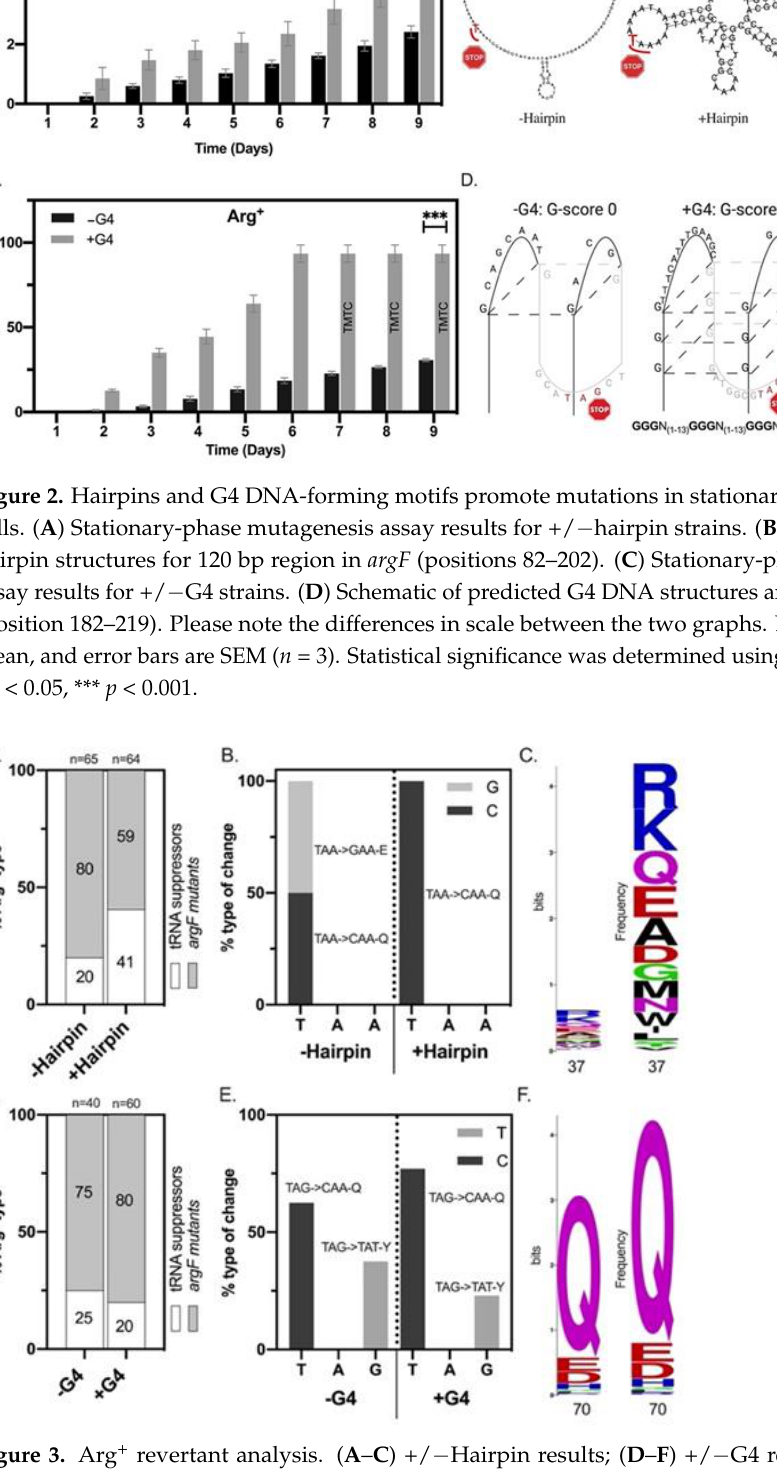
Figure 3. Arg + revertant analysis. ( A – C ) +/ − Hairpin results; ( D – F ) +/ − G4 results. ( A , D ) The proportion of tRNA suppressors from Arg + population sampled that arose from day 5–9. ( B , E ) argF sequencing results from Arg + mutants that were determined not to be tRNA suppressors. ( C , F ) Protein alignment analysis of positions containing the nonsense codons 37 and 70.